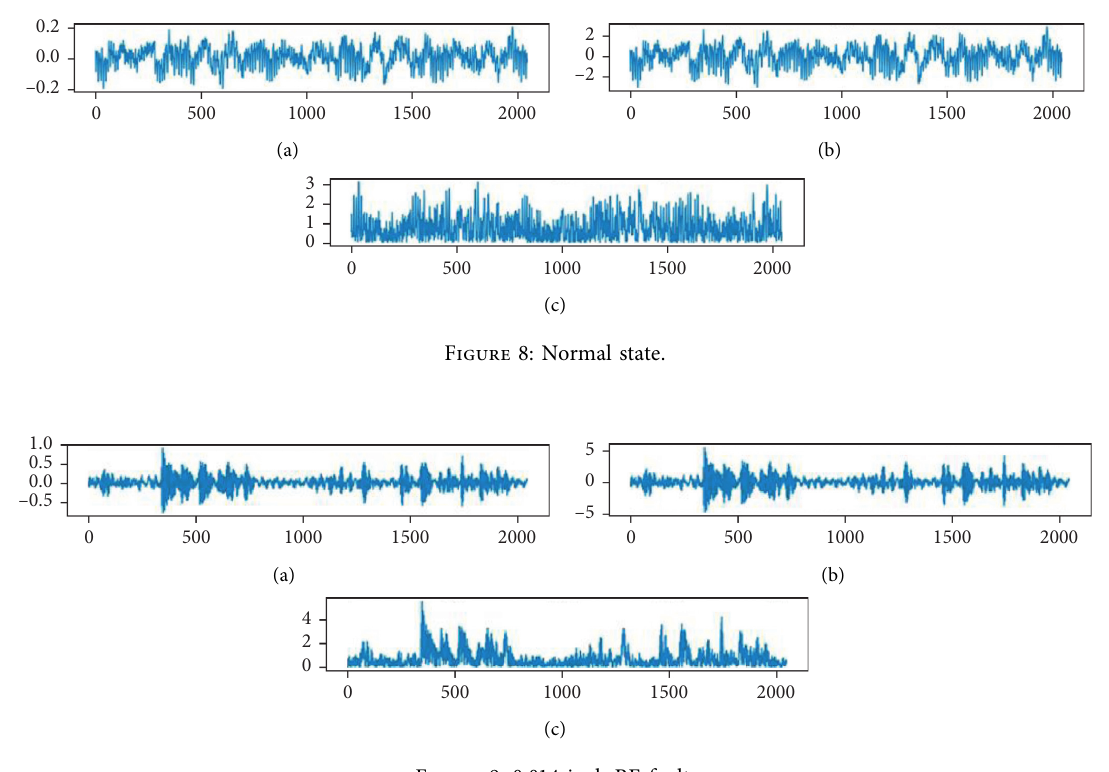
Figure 9: 0.014-inch RE